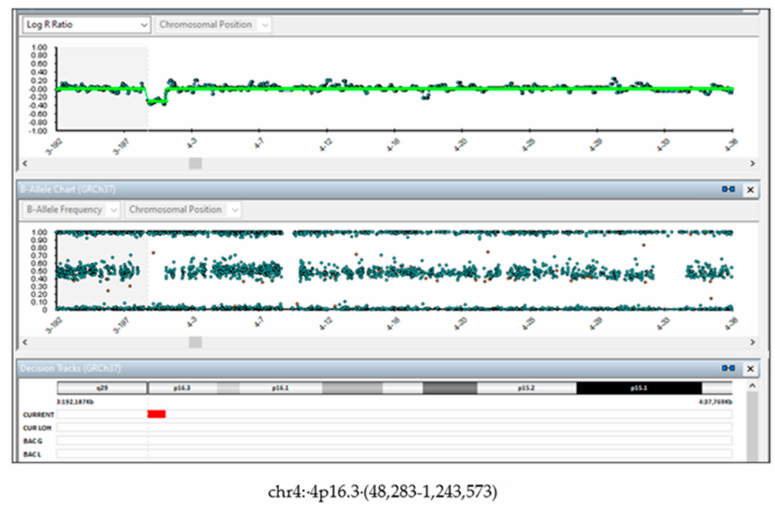
Figure 3. SNP-array on fetus tissue. DNA from fetal skin showed the de novo 1.2 Mb deletion (4p16.3